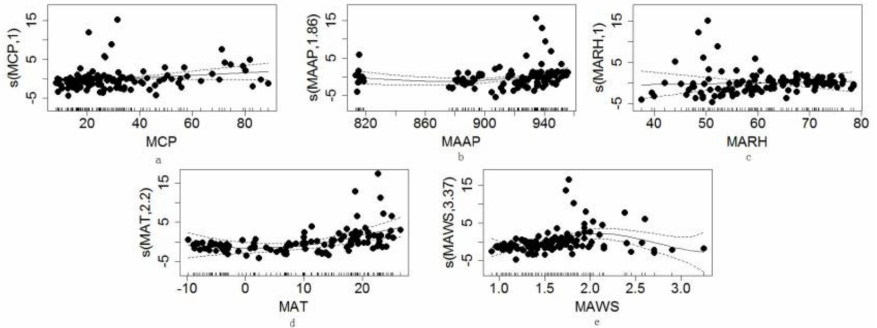
Figure 5. Effect of multifactorial climatic factors on the variation of HFMD concentrations. (( a ). MCP, ( b ). MAAP, ( c ). MARH, ( d ). MAT, ( e ).